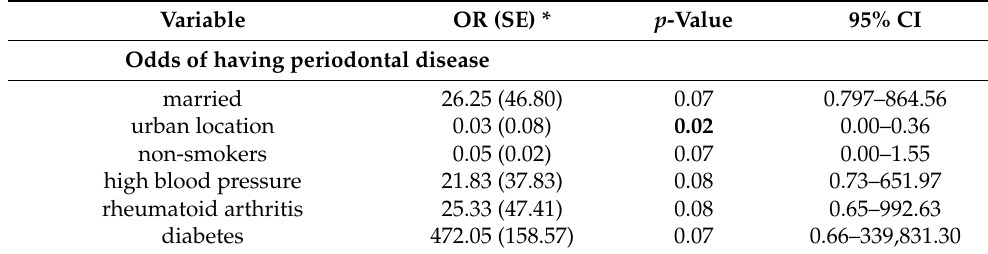
Table 2. Logistic regression model for the variables of periodontal disease and dental